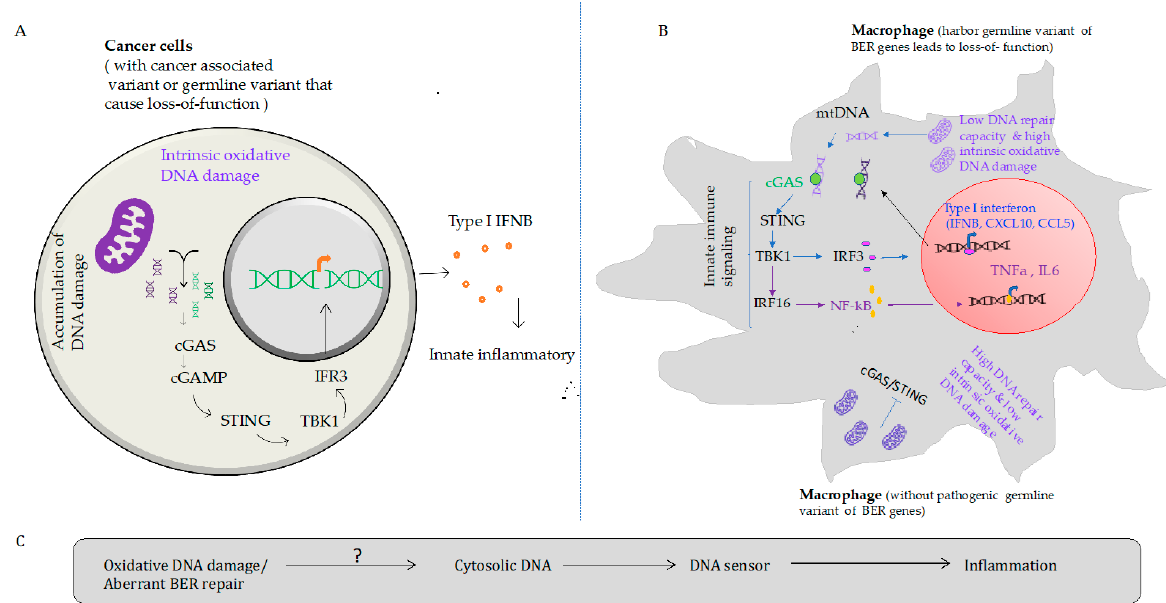
Figure 2. Aberrant BER induces DNA-sensor-mediated inflammatory signaling. The cGAS-STING signaling pathway in BER deficient tumor cells ( A ) and immune cells ( B ). In both cases, tumor- associated mutation of BER genes or germline variant associated with impaired BER function in cancer cells and/or macrophage may contribute to accumulation of unrepaired endogenous oxidative DNA damage product that may leak to cytosol and stimulate cGAS and produce second messenger 2 (cid:48) ,3 (cid:48) -cGAMP. After 2 (cid:48) ,3 (cid:48) -cGAMP binds to STING protein and then phosphorylate TBK1 that leads to IRF3 activation and/or NF- κ B to facilitate their translocation into the nucleus and drives the expression of inflammatory genes, including Type I interferon. In contrast, macrophages with high DNA repair capacity (without pathogenic variant of BER gens) suppress innate immune signaling mediated by cGAS/STING. ( C ) Schematic representation of impaired BER function will likely leads to accumulation of oxidative stress related DNA damage and may trigger the release of cytosolic DNA and cGAS/STING dependent inflammatory